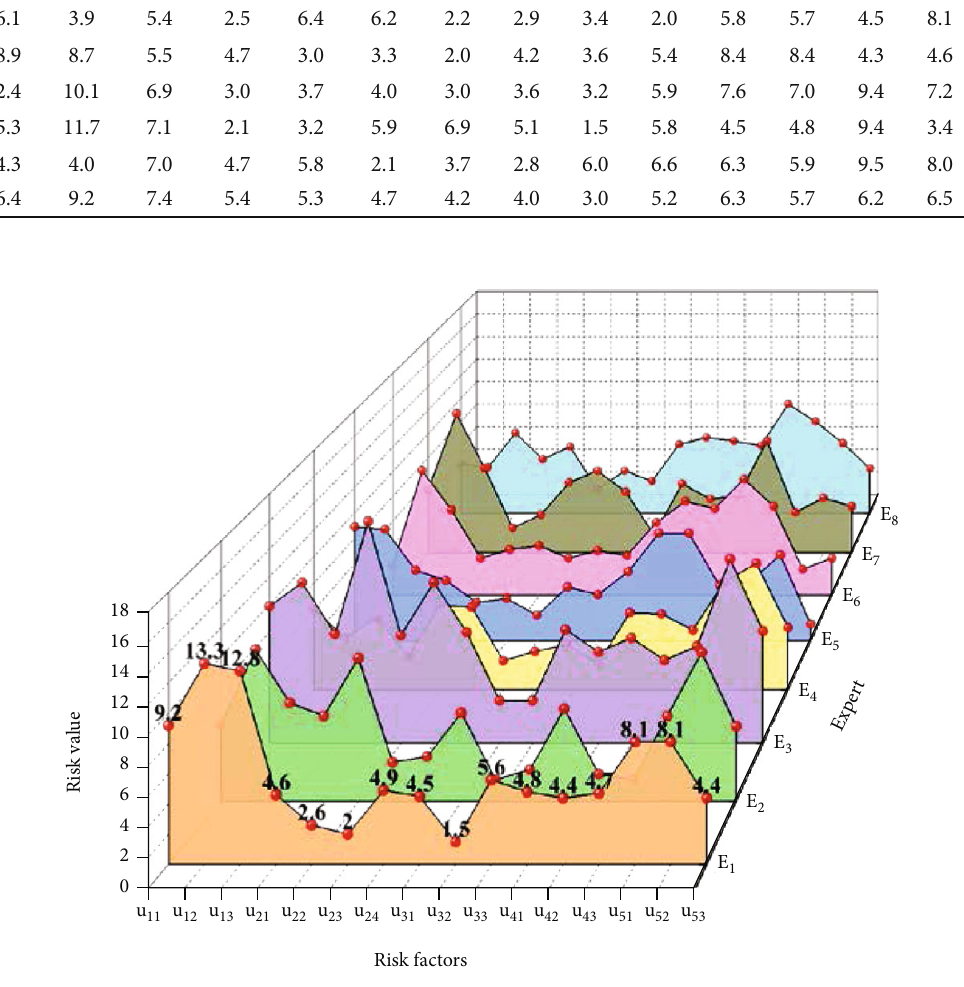
Figure 5: Expert rating summary fi gure. Table 10: Weighting of foundation pit construction risk